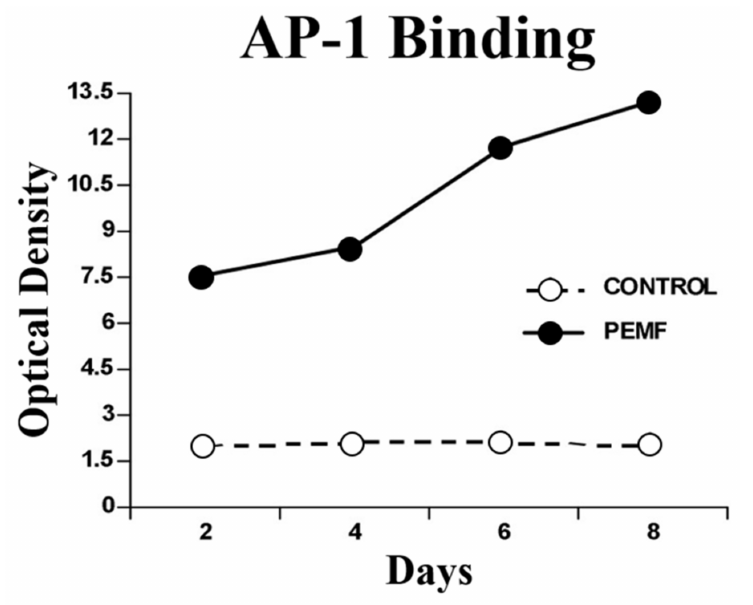
Figure 13. PEMFs increase AP-1 binding to TGF- β . Electromobility shift assay (EMSA) of nuclear extracts demonstrating binding of the transcription factor AP-1. At all time points, the binding in the PEMF-exposed ossicles was significantly higher, indicating an increased level of transcriptional activity. Adapted from Ref. [23]. 2004. Roy K. Aaron.